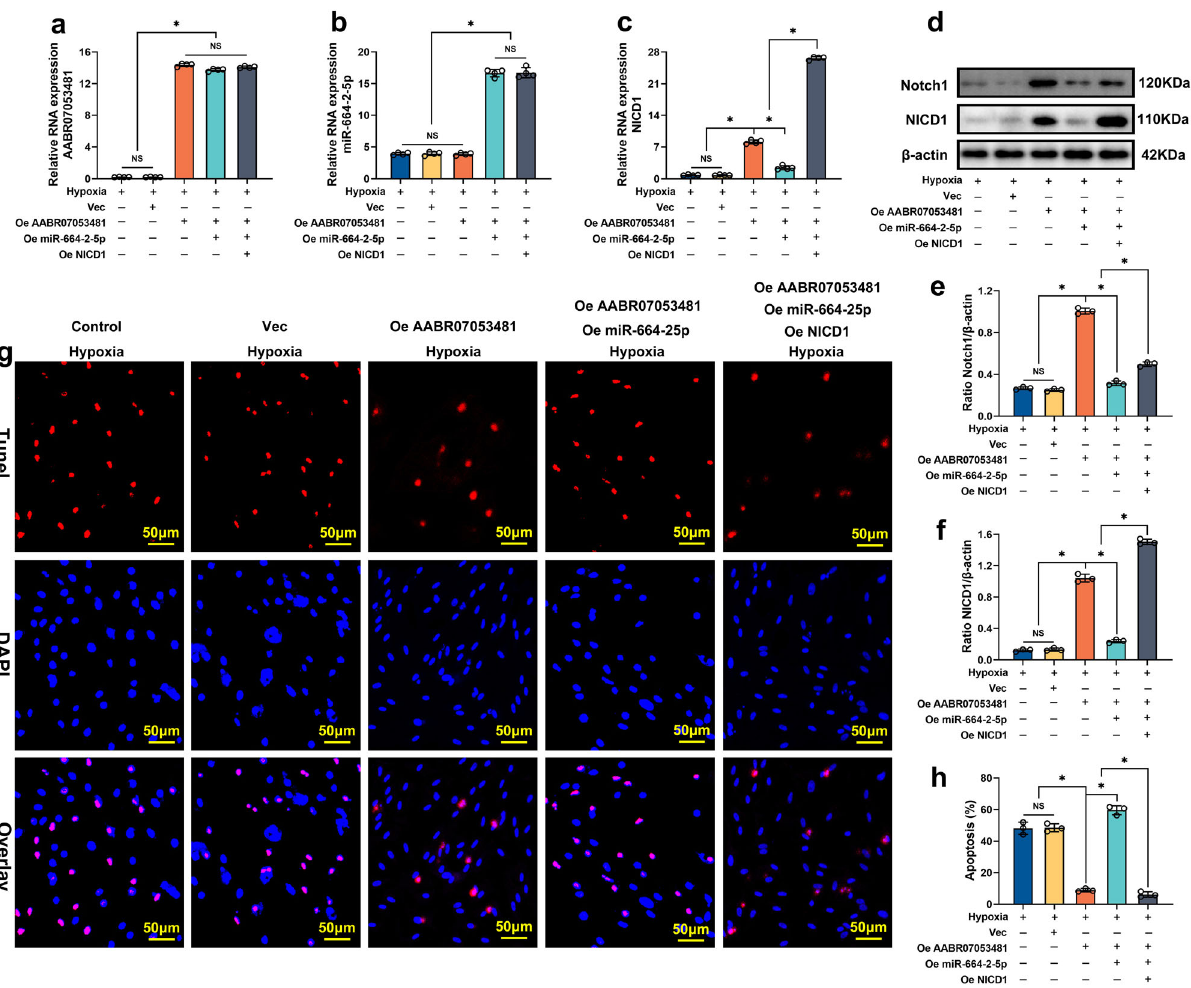
Fig. 5 The LncAABR07053481/miR-664-2-5p/ Notch1 axis is involved in the regulation of hypoxia-induced apoptosis of BMSCs. a – c The expressions of LncAABR07053481, miR-664-2-5p, and NICD1 were detected by qPCR ( n = 4). d – f The expression levels of Notch1 and NICD1 were detected by western blotting ( n = 3). g , h Detection of BMSC apoptosis under different conditions by TUNEL/DAPI ( n = 3). Data were shown as mean ± SD. * P < 0.05; In ( a – c , e , f , h ), statistical signi fi cance was calculated by one-way ANOVA with Tukey ’ s post hoc